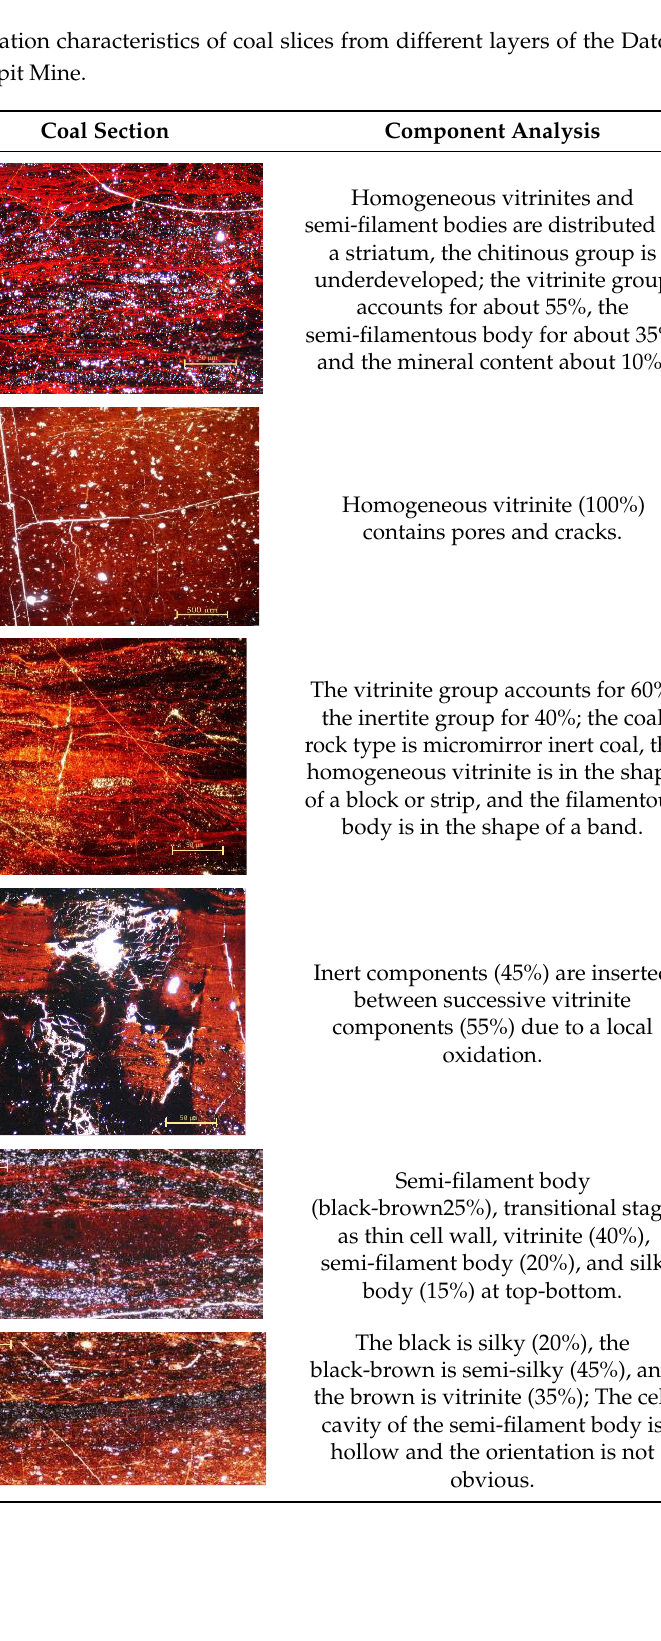
filled with matrix vitrinite.